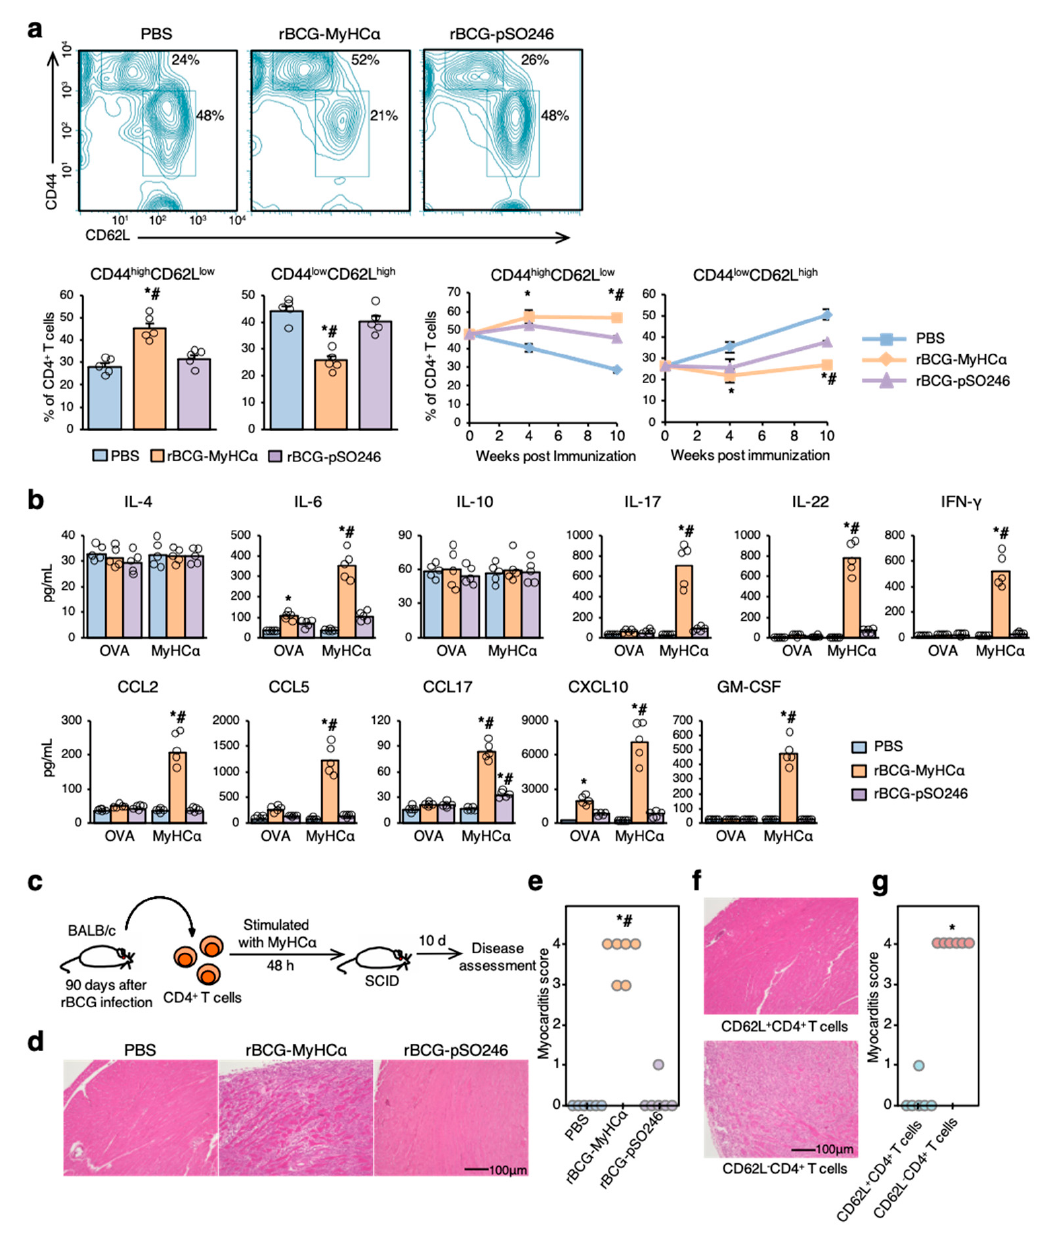
Figure 6. Assessment of CD4 + T-cell function. Immunization protocol is shown in Figure 5a. ( a ) Flow cytometric analysis of the heart-infiltrating CD4 + T cells at 12 weeks after rBCG immunization. Graphs show the percentage of the effector (CD44 high CD62L low ) and naïve (CD44 low CD62L high ) T cells in CD4 + T cells ( n = 5 per group). * p < 0.05 vs. PBS and # p < 0.05 vs. rBCG-pSO246 by Kruskal-Wallis analysis with a post hoc Steel-Dwass test. ( b ) Bar graphs show MyHC α -specific cytokine production of CD4 + T cells isolated at 12 weeks after rBCG immunization. n = 5 per group. * p < 0.05 vs. PBS, # p < 0.05 vs. ovalbumin (OVA) stimulation by Kruskal-Wallis analysis with a post hoc Steel-Dwass test. ( c ) CD4 + T cells were isolated from rBCG-immunized mice and stimulated with MyHC α for 48 h. After stimulation, the CD4 + T cells were transferred into SCID mice. ( d ) Representative H&E-stained section of the hearts at 10 days after adoptive transfer. ( e ) Myocarditis severity in heart sections stained with H&E ( n = 6 mice/group). * p < 0.05 vs. PBS and # p < 0.05 vs. rBCG-pSO246. ( f ) CD4 + T cells were separated into CD62L + cells and CD62L − cells, and both cell populations were transferred into SCID mice. The representative H&E-stained section of the hearts at 10 days after adoptive transfer ( f ) and the myocarditis score ( g ) are shown. * p < 0.05 vs. CD62L + CD4 + T-cell